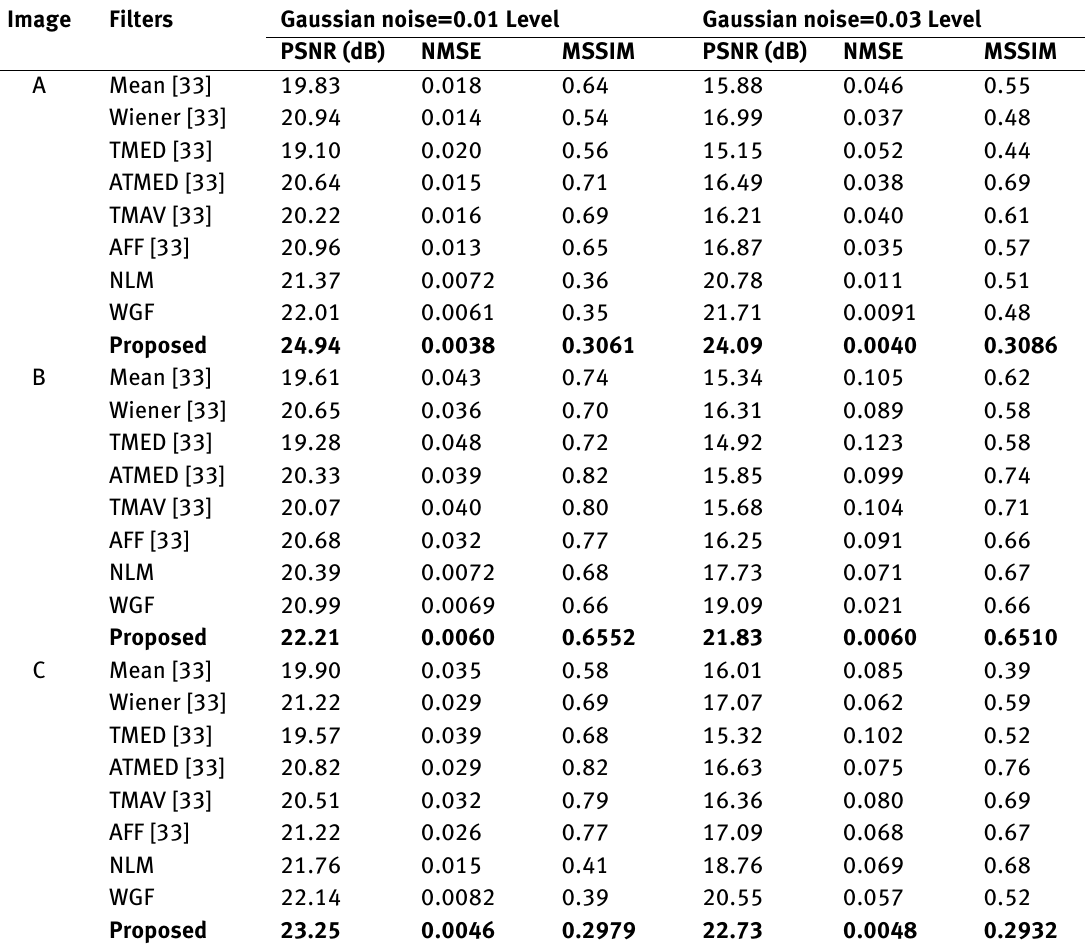
Table 5: Comparative analysis between modified fuzzy set filter and existing filters Image Filters